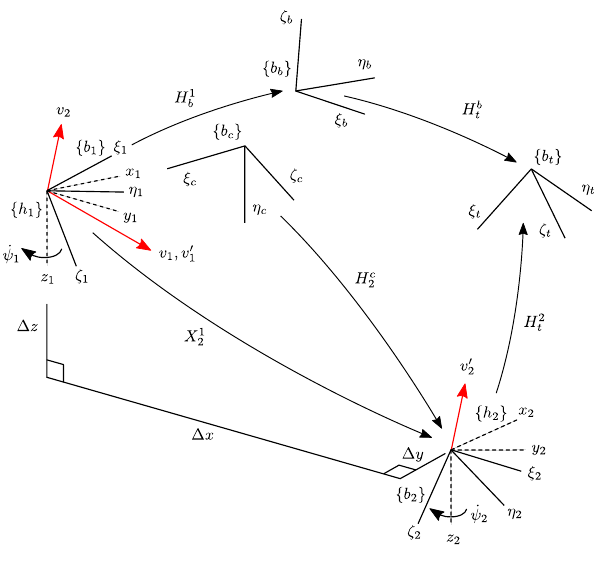
Figure 9: Coordinate systems as they are used in the sensor fusion algorithm to describe the rel- ative position and orientation between the